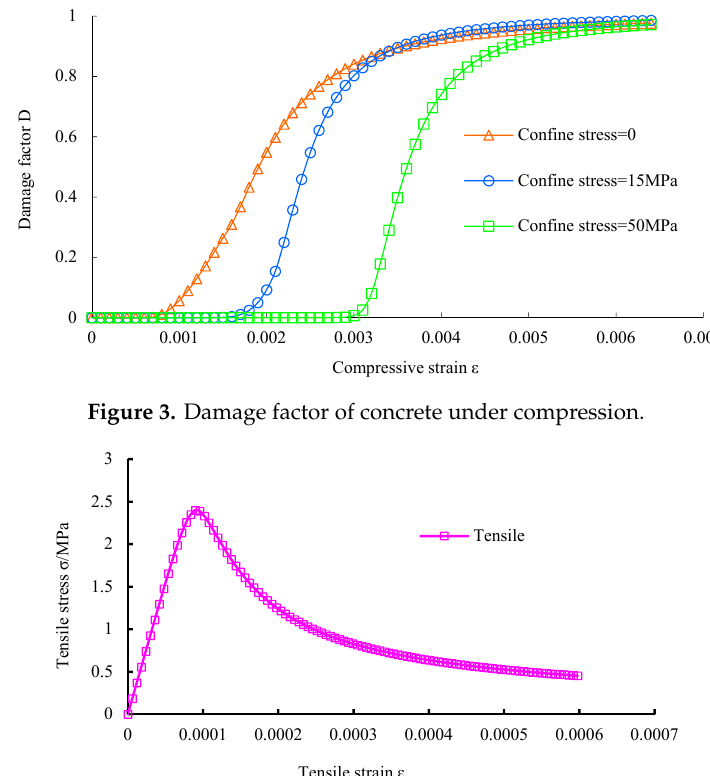
Figure 2. Stress-strain curve of concrete under compression.